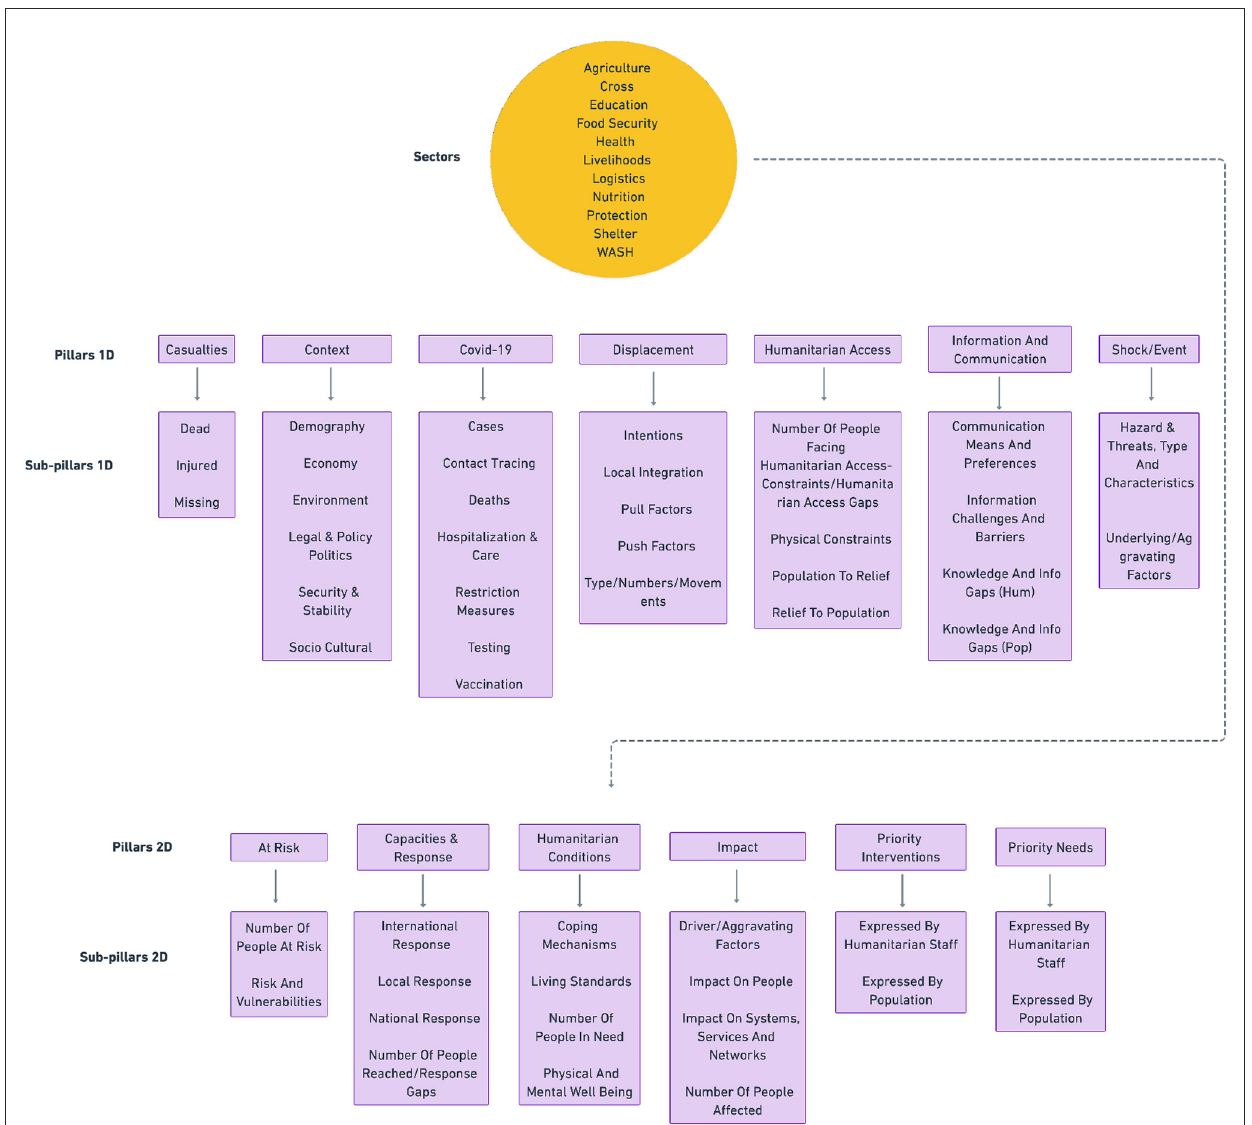
FIGURE3 Humanitarian analytical framework developed from DEEP annotations, and used to annotate text in a multidimensional and hierarchical fashion in HUMSET (Fekih et al., 2022).